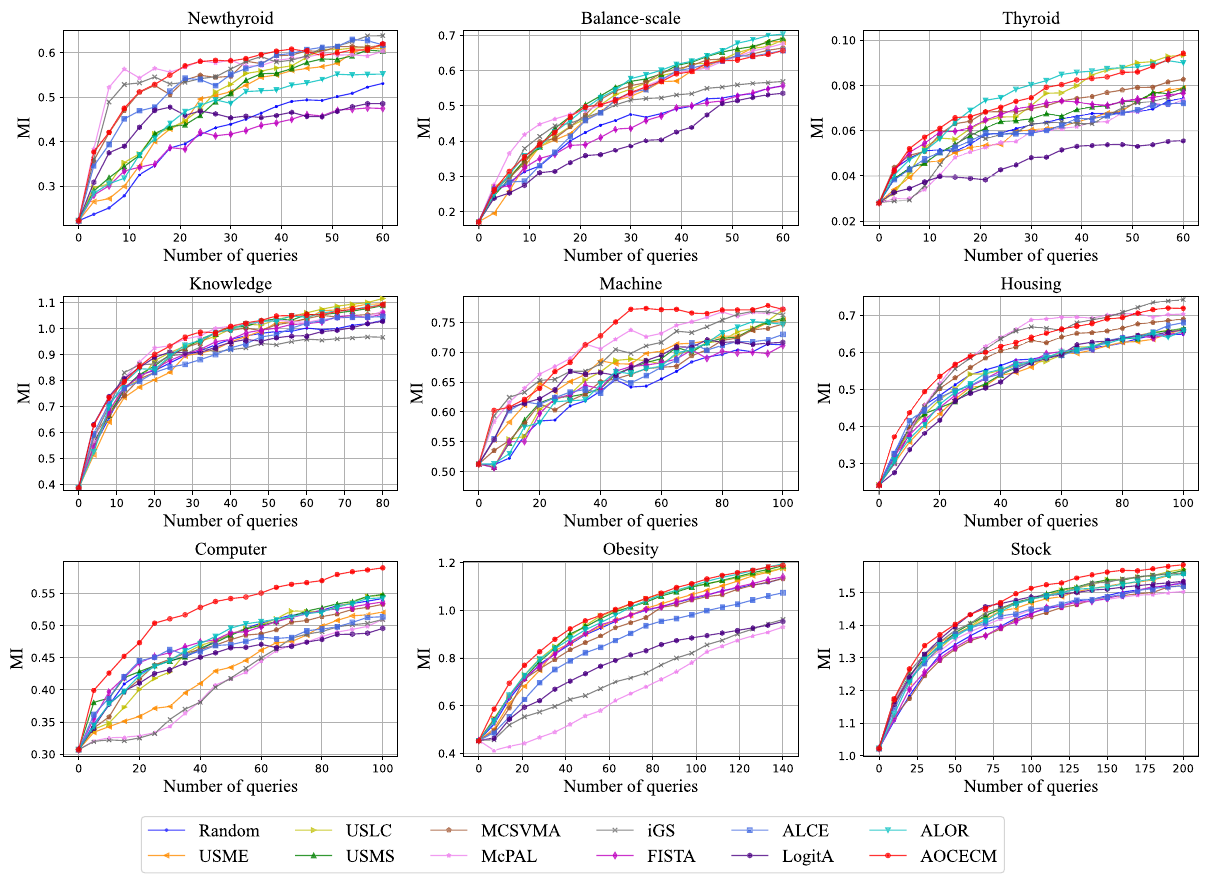
Figure 5. Learning curves of MI for the twelve compared